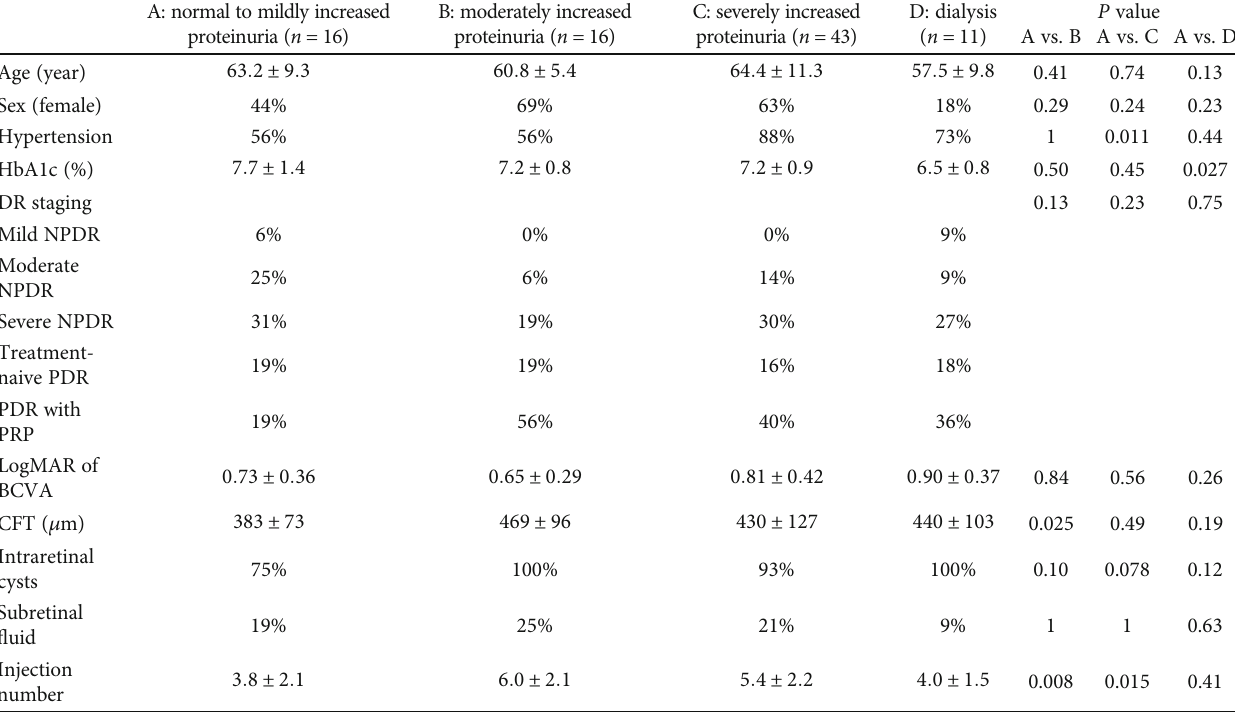
Table 1: Demographic data, visual acuity, optical coherence tomography characteristics, and injection number in four di ff erent proteinuria groups at